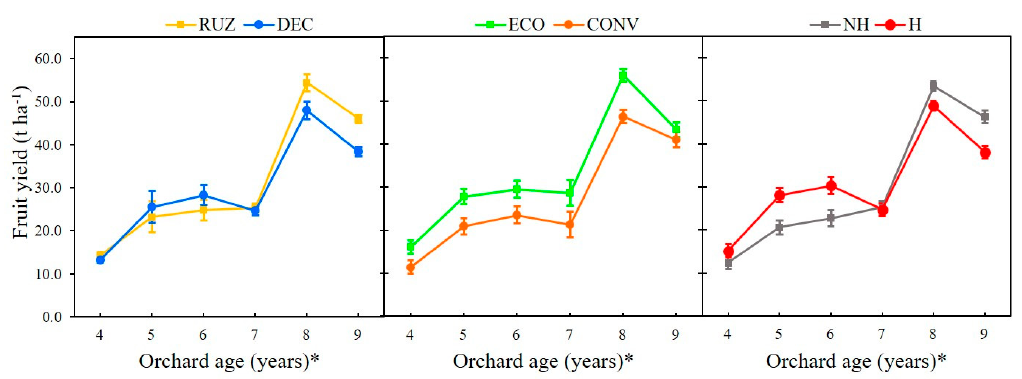
Mirim, São Paulo, 2014–2019). Legend: RUZ = Urochloa ruziziensis , DEC = U. decumbens , ECO